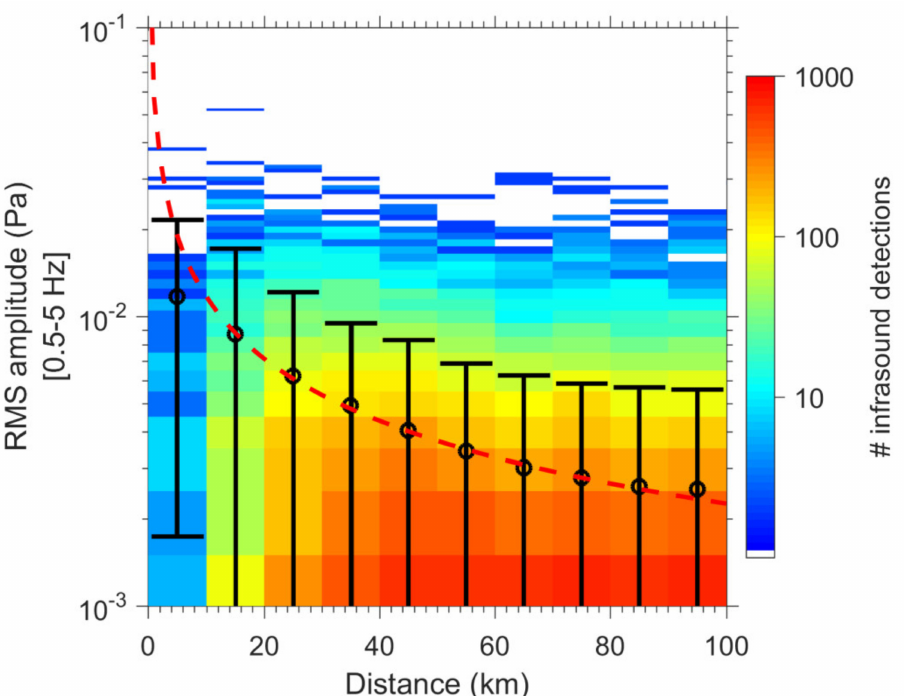
Figure 7. Distribution of infrasound detections vs. RMS amplitude and distance. The black circles give the mean amplitude value per 10 km distance bins with their error bars. The red dashed curve is the power fit over these mean